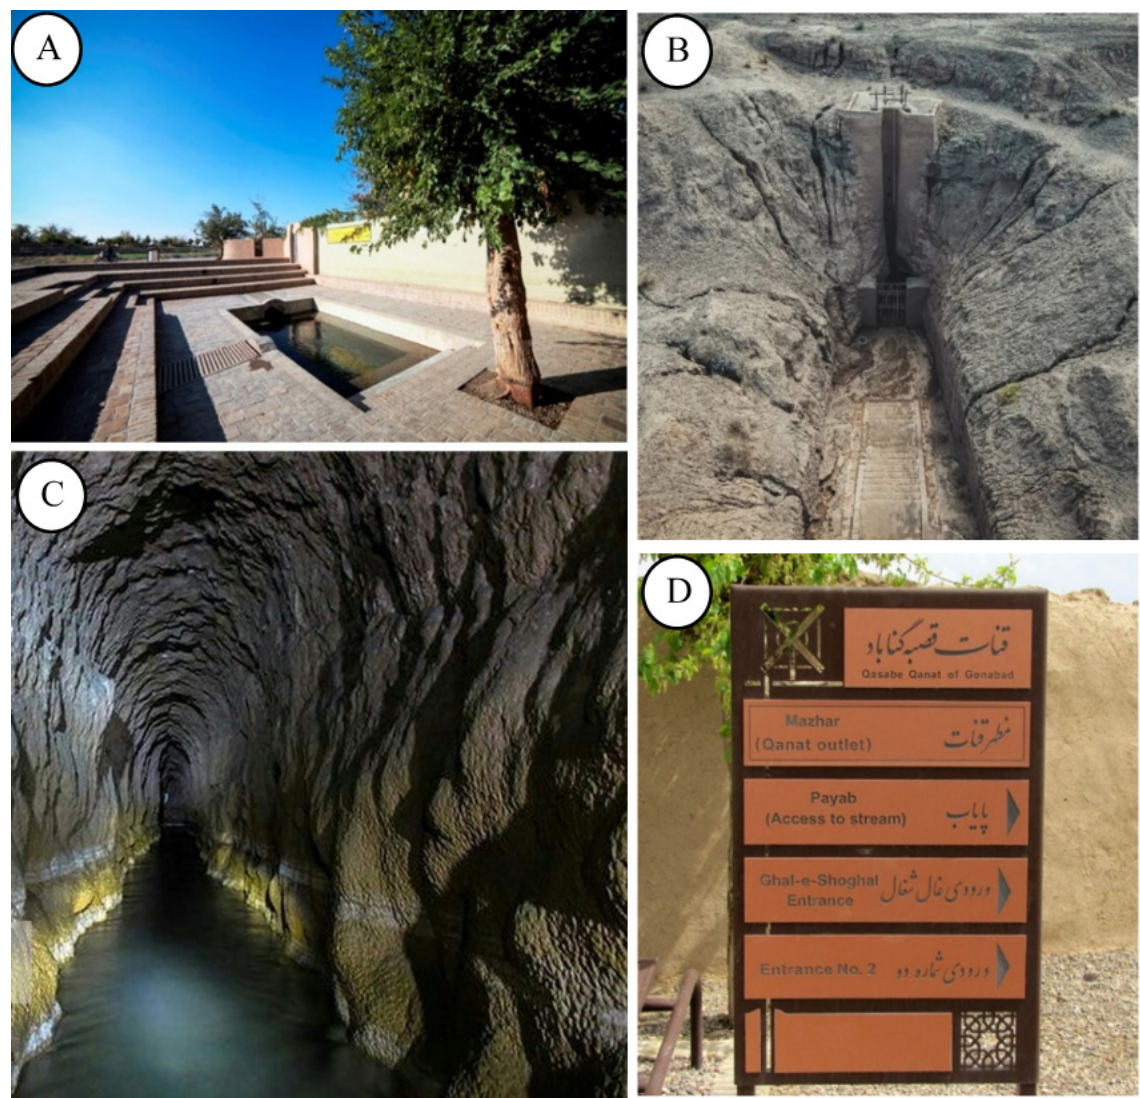
Figure 2. Some pictures from Gonabad Qasabeh qanat. A) qanat outlet B) Entrance No.1 C) A view from inside the qanat D) Qanat entrance